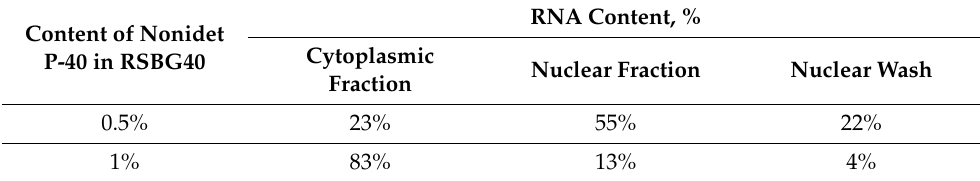
Table A3. Quantity of RNA extracted during cell lysis and fractionation by